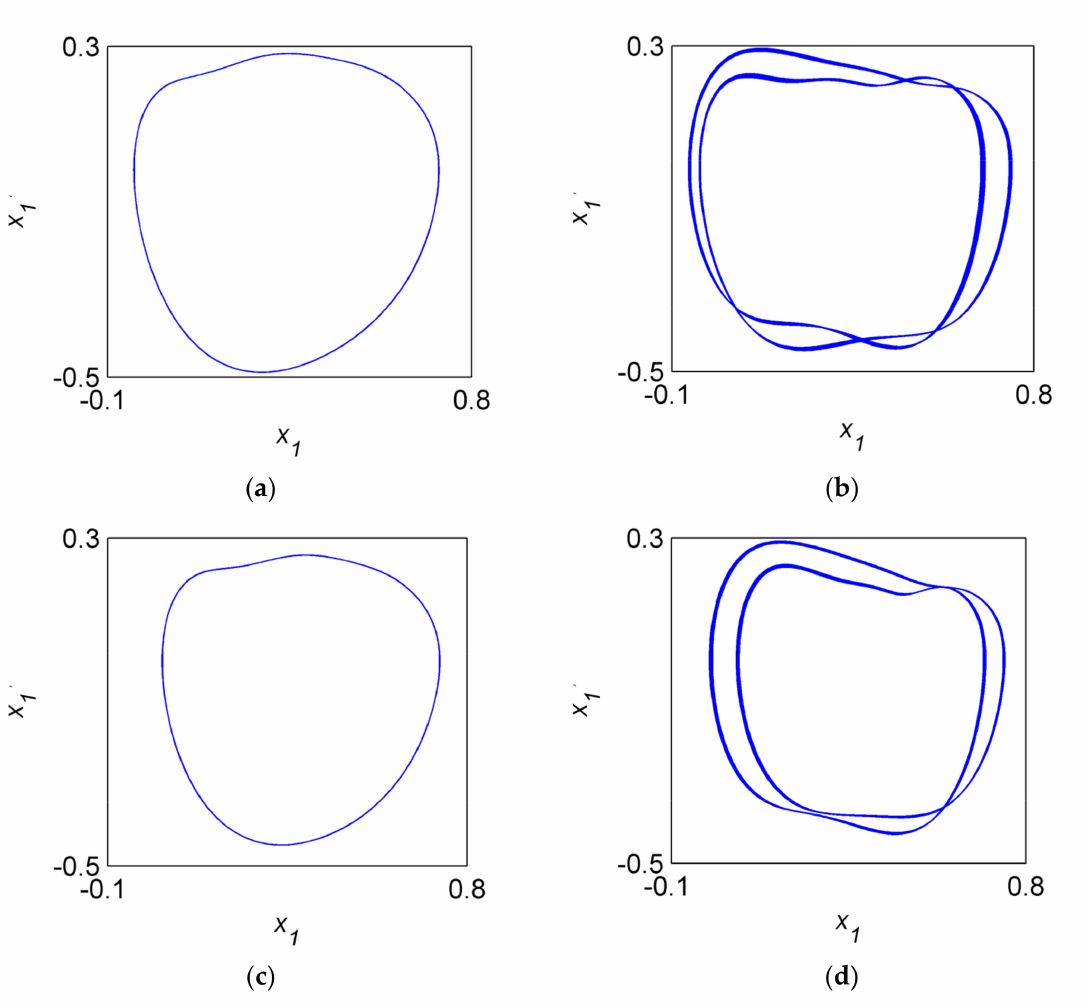
Figure 10. The phase portraits of o 1 when ω = 730 rad/s. ( a ) The oil-filmed system. ( b ) The cracked system. ( c ) The rub-impacted system. ( d ) The coupled